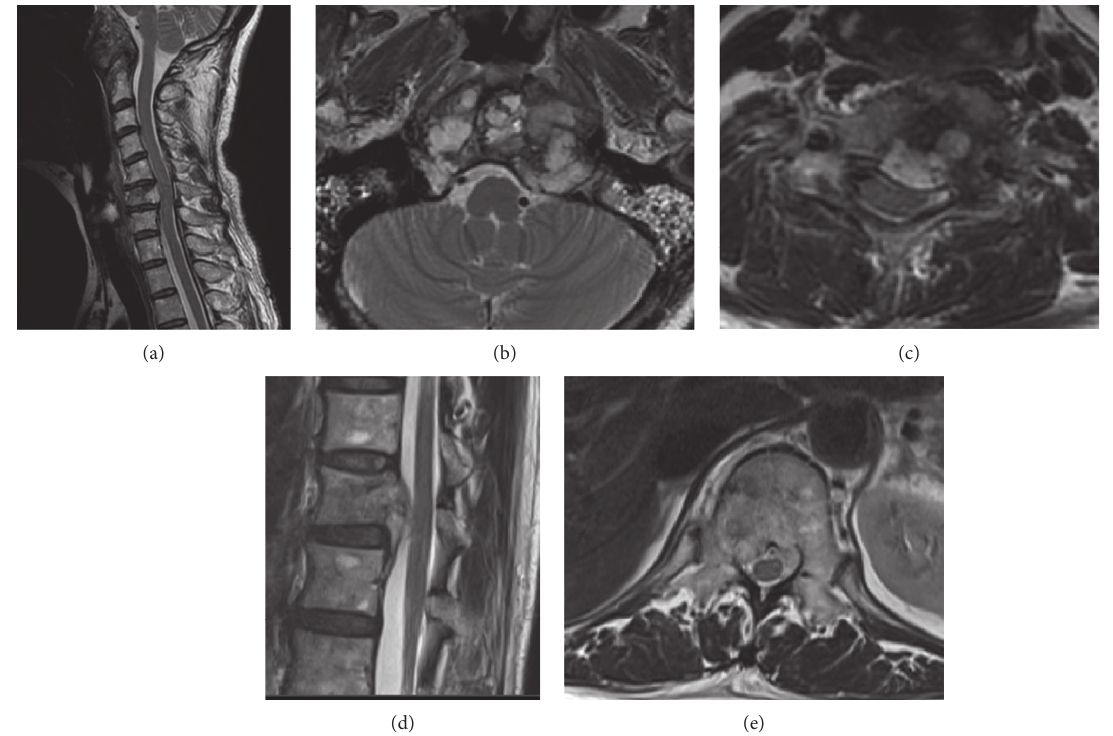
Figure 3: MRI at first presentation. (a) Sagittal image of tumors at skull base and C6, axial image of tumor at (b) skull base and (c) C6, and (d) sagittal and (e) axial images of the tumor at T12. Table 1: Nonsynonymous somatic mutations and fusion gene.